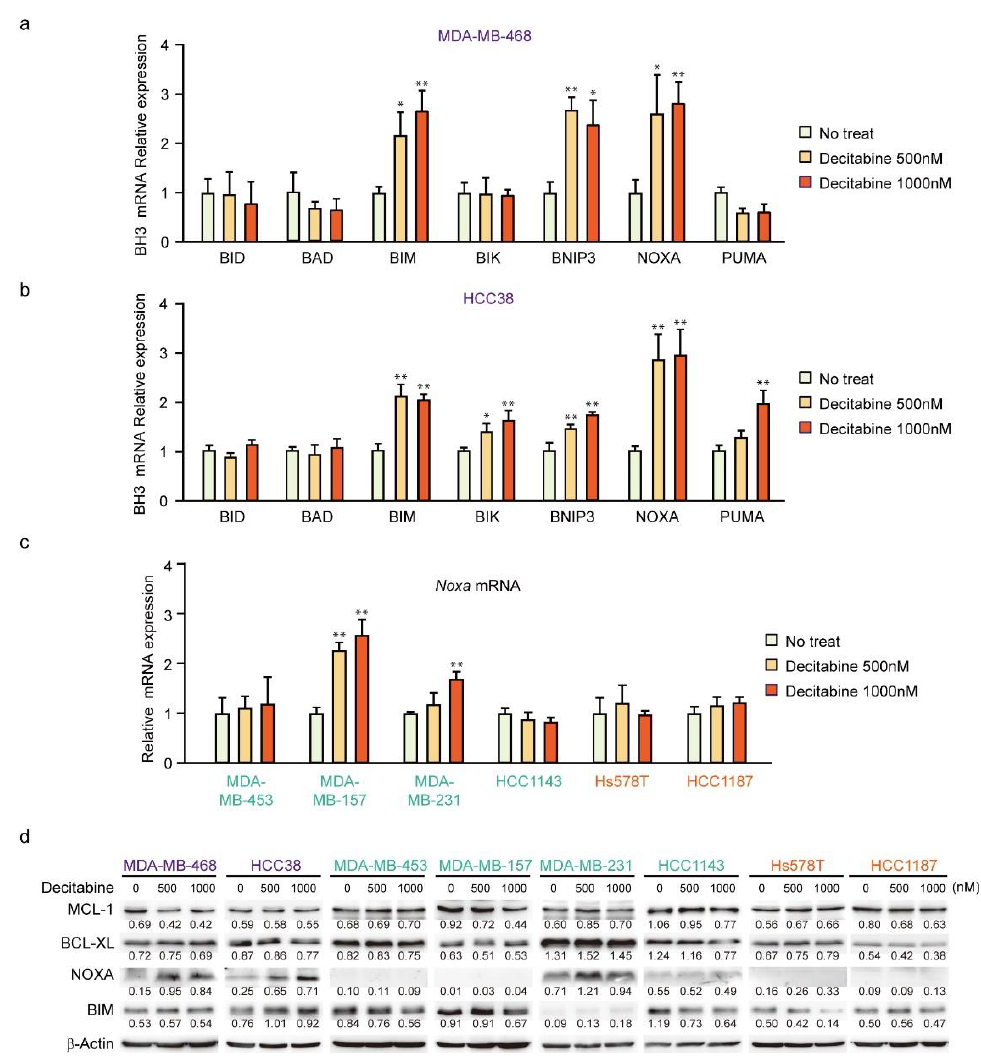
Figure 3. Expression of BCL2 family genes in TNBC cell lines. ( a – d ) Cells were exposed to the indicated amounts of decitabine (500 or 1000 nM). After treatment for 72 h, the mRNA levels in MBA-MB-468 ( a ) and HCC38 ( b ) cells were measured by quantitative real-time PCR. The levels of NOXA mRNA in indicated cells were determined by qPCR ( c ). Error bars indicate SD ( n = 3). The data are expressed as the mean ± SD of triplicate experiments. *, p < 0.05; **, p < 0.01. ( d ) Equal amounts of total cell lysate were subjected to immunoblot analysis with the indicated antibodies. Numbers below blots represent the relative band intensity of each protein normalized to the signal intensity of β -actin. The uncropped immunoblot images can be found in Figure S2.